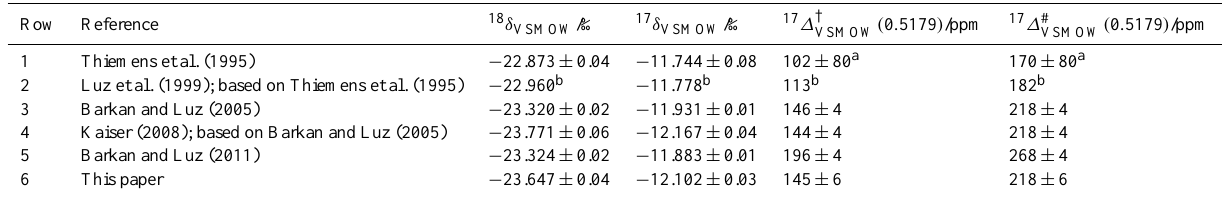
Table 1. Historic and new measurements of the relative oxygen isotope ratio differences between Vienna Standard Mean Ocean Water (VS- MOW) and Air-O 2 ( 17 δ VSMOW , 18 δ VSMOW , 17 ∆ VSMOW ) . For clarity, all values are shown with the same number of decimals, irrespective of their uncertainty.